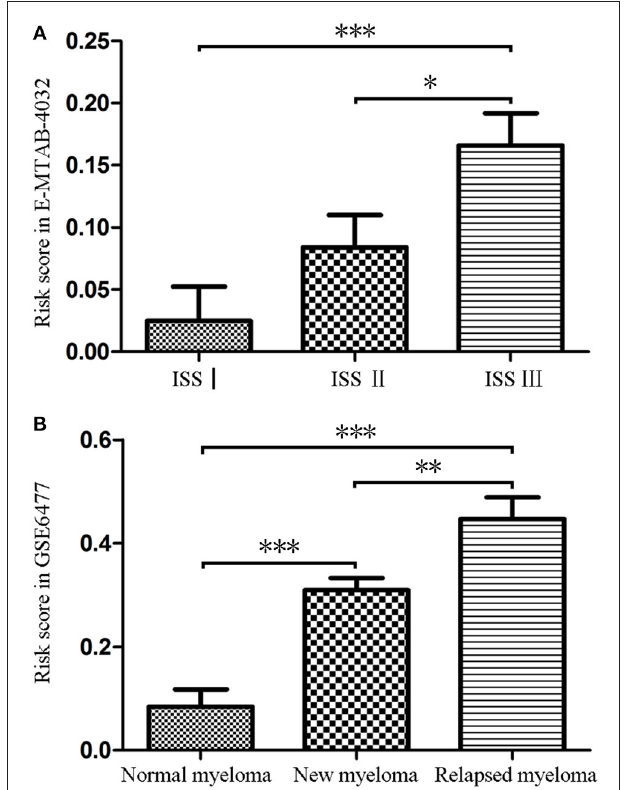
FIGURE 2 | The risk score of the signature in GSE6477 and E-MTAB-4032. (A) The risk score was increased in MM patients with ISS III disease and ISS IIcompared with that in MM patients with ISS Idisease. (B) The risk score of was significantly upregulated in newly diagnosed MM and relapsed MM compared with that in normal plasma cells. * P < 0.05, ** P < 0.01, and *** P < 0.001.